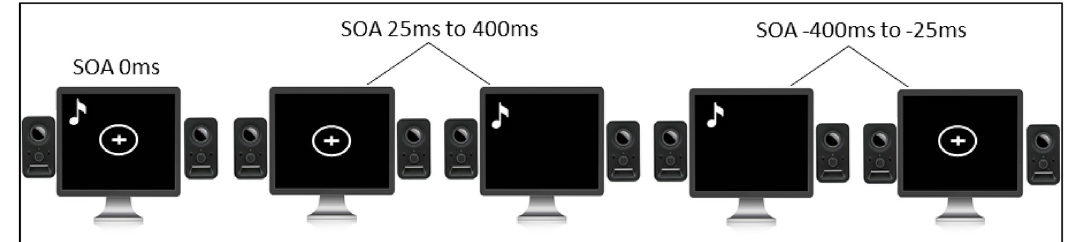
Fig 2. Paradigm of the simultaneity judgement